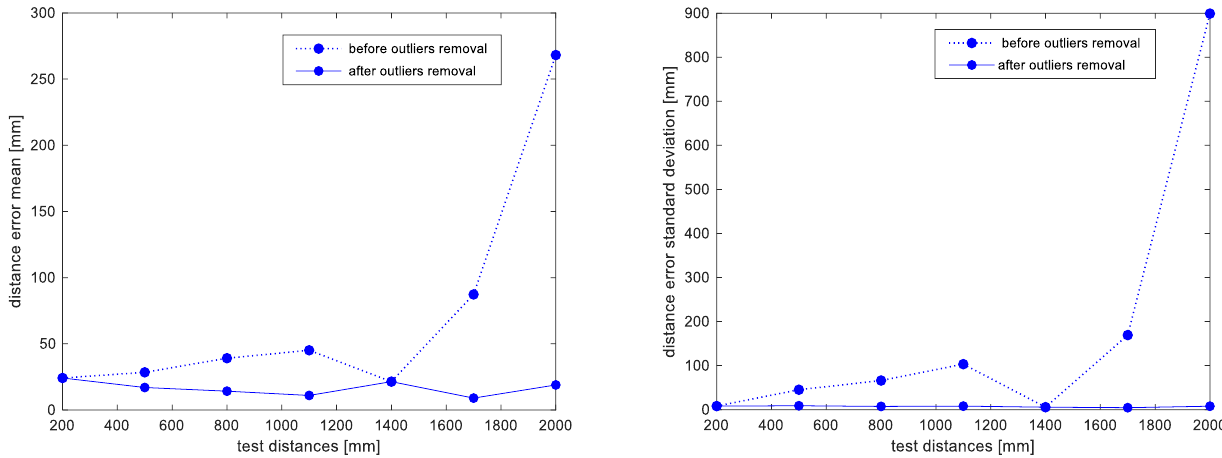
Figure 6. Mean ( left ) and standard deviation ( right ) of the estimated distance error for the couple of nodes (mobile node – anchor 1). Table 2. Mean and standard deviation of the estimated distance error for the couple of nodes (mobile node–anchor 1).